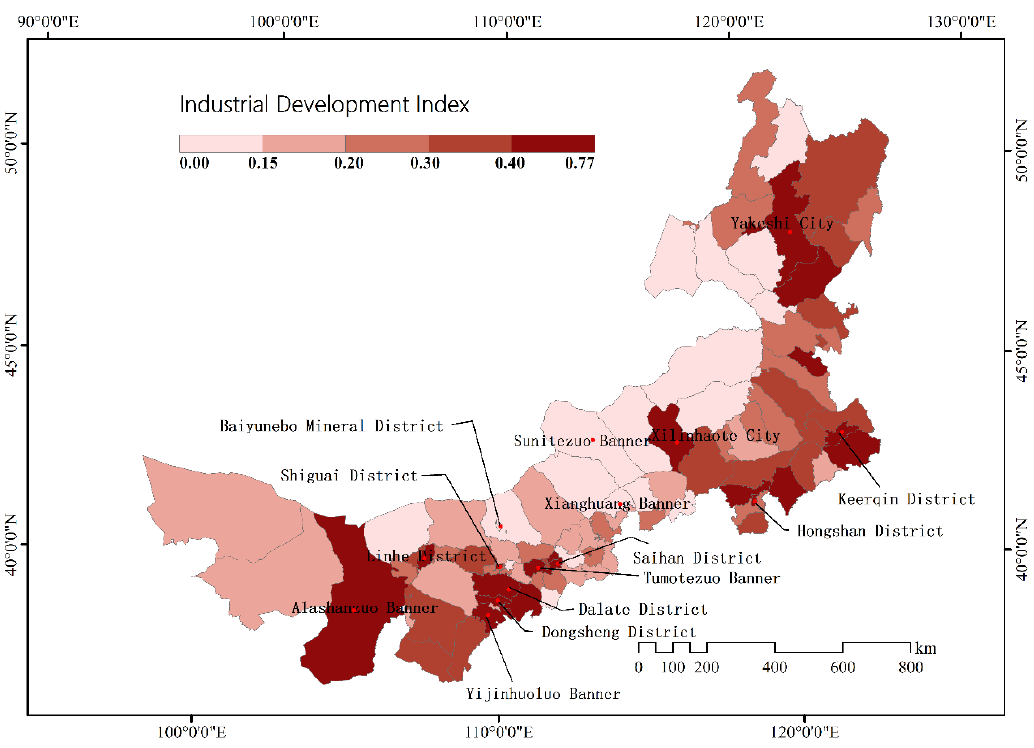
Figure 2. Spatial distribution of the industrial development index in Inner Mongolia in 2020.